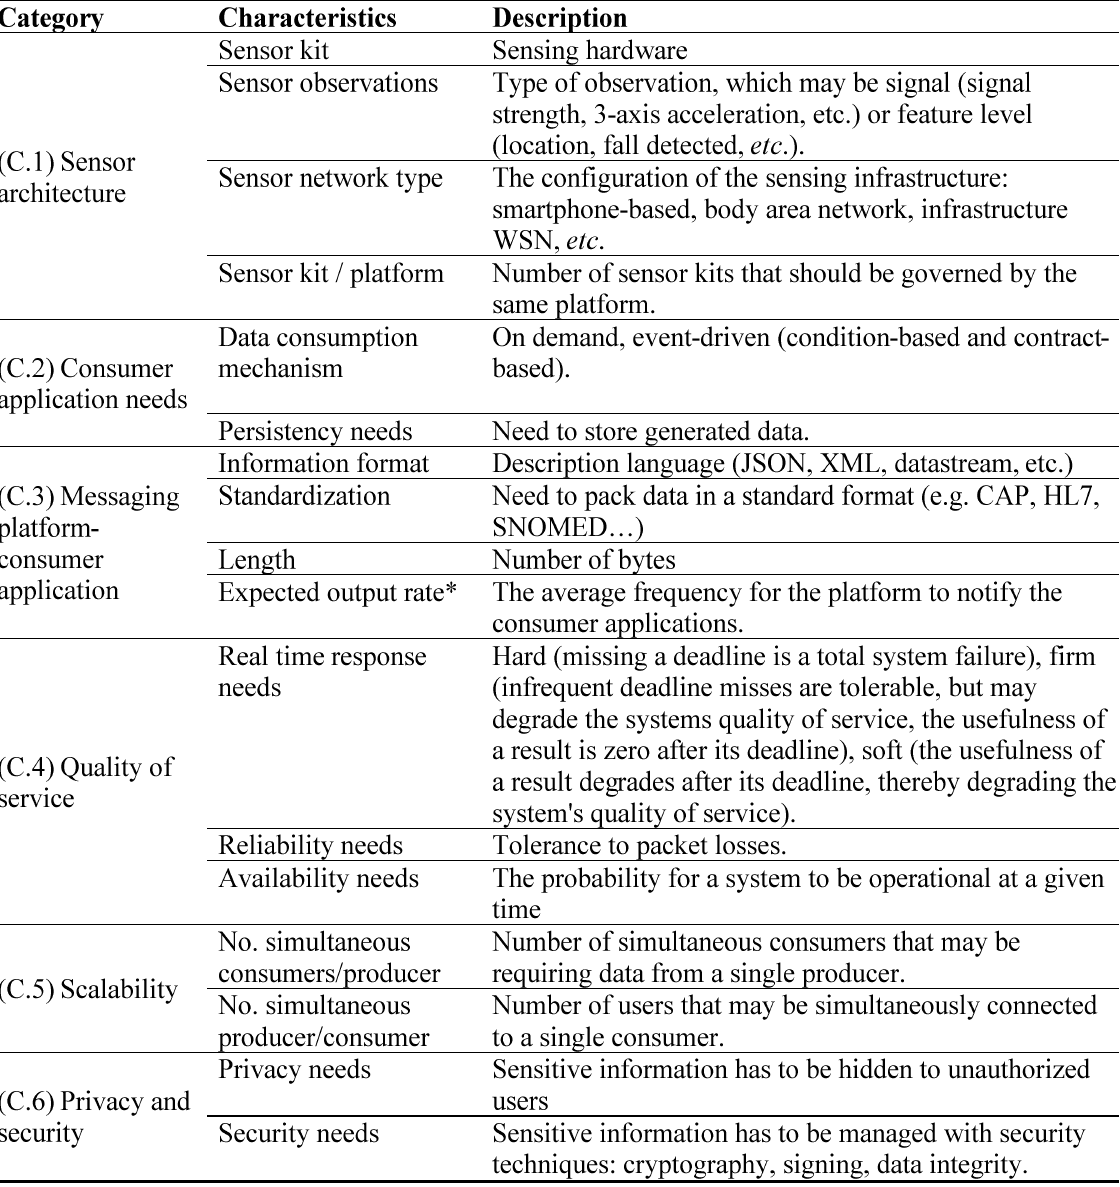
Table 1. Model to analyse requirements of